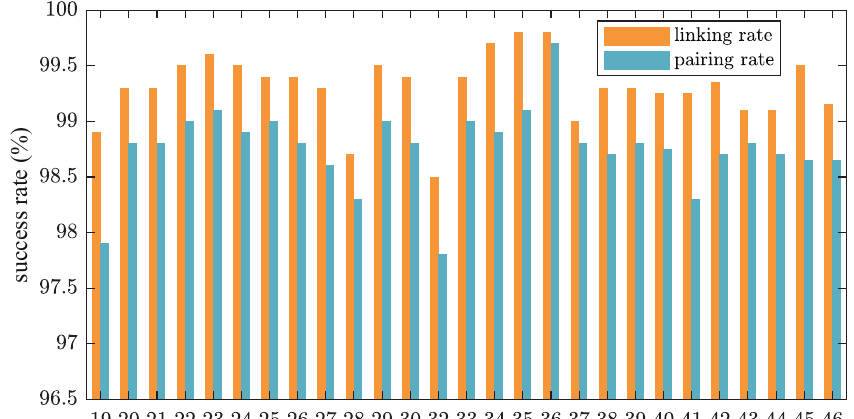
Figure 4: Statistics of BDS dual one - way